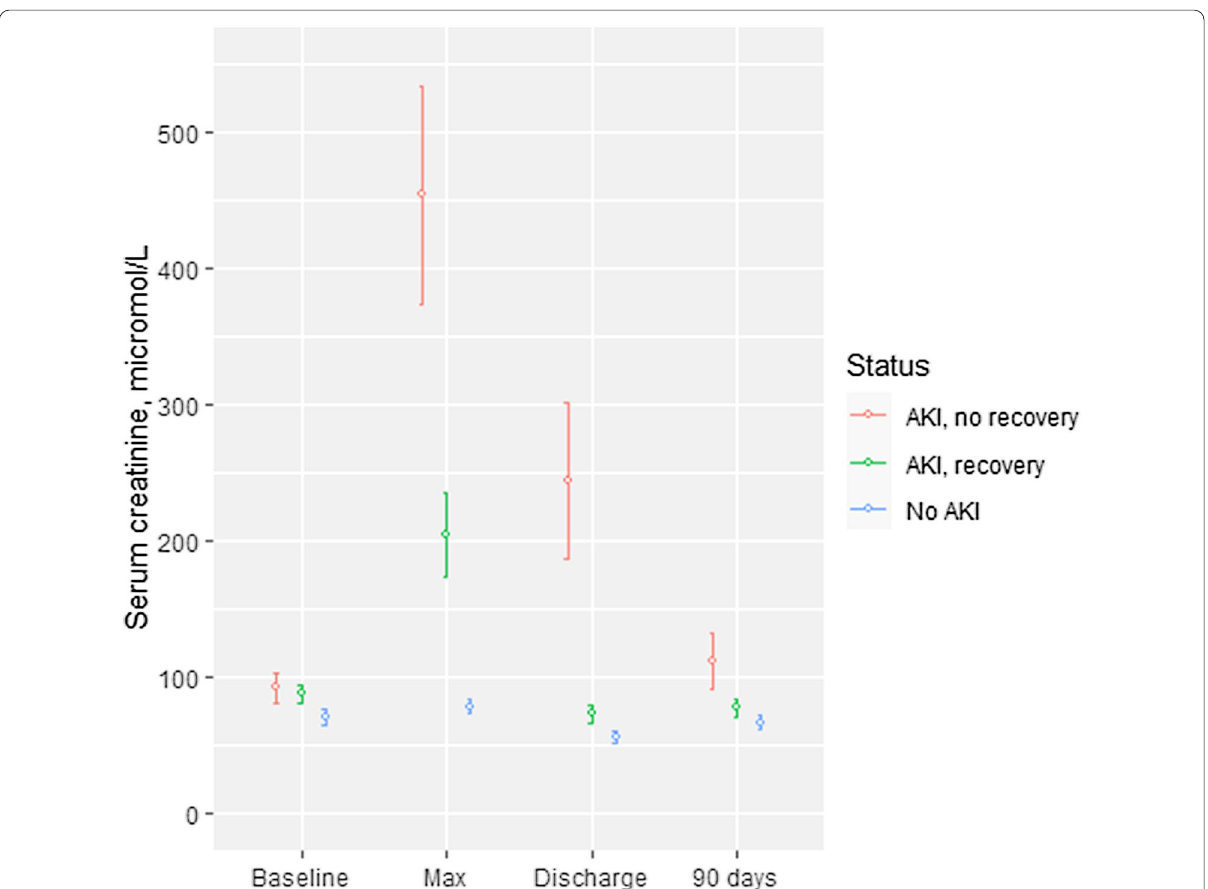
Fig. 2 Mean (95% CI) serum creatinine at different time points from baseline to 90 days after hospitalisation in patients who survived, were not dialysis-dependent at hospital discharge, and had serum creatinine measurement available at 90 days (n